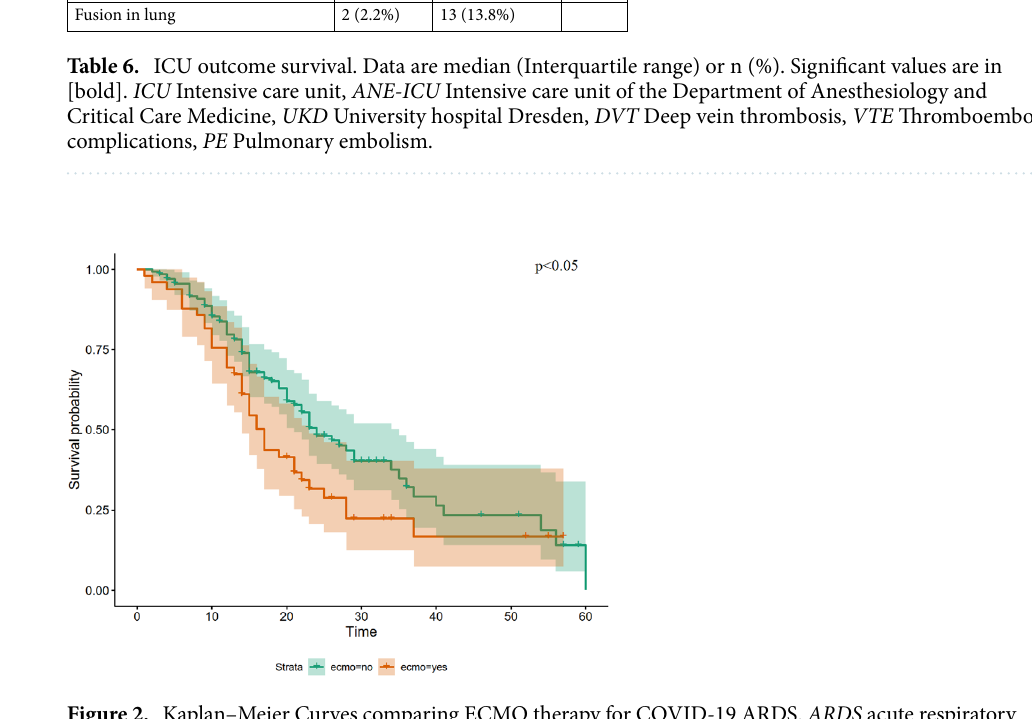
Figure 2. Kaplan–Meier Curves comparing ECMO therapy for COVID-19 ARDS. ARDS acute respiratory distress syndrome, ECMO extracorporeal membrane oxygenation. Time is indicated in days. Group comparison were performed using Log Rank